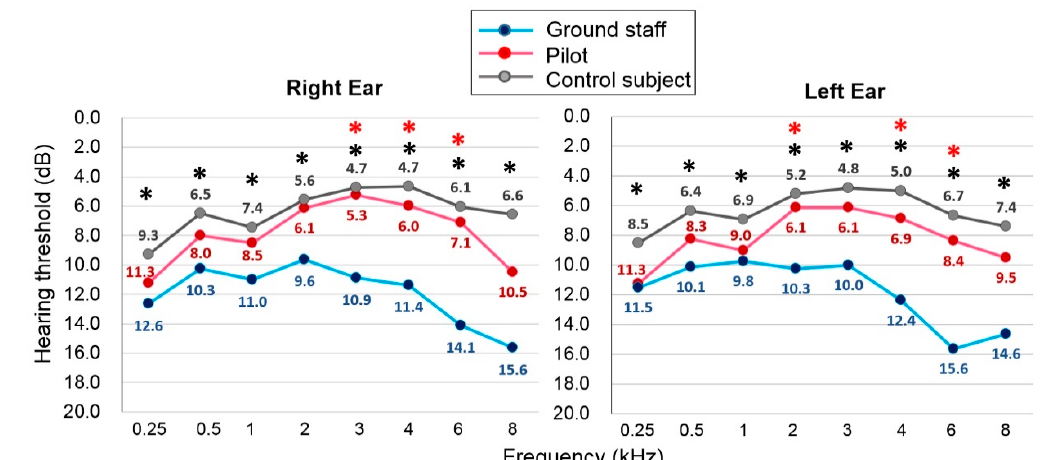
Figure 1. Recent audiometric outcomes assessed with conventional pure-tone audiometry. The value of each data point indicates the average threshold across subjects at the corresponding frequency. Comparisons between groups were performed using the Kruskal—Wallis test, followed by Scheffe’s post-test. * black asterisk indicates p < 0.05 when comparing the ground staff group with the control subjects. * red asterisk indicates p < 0.05 when comparing the ground staff group with the pilot group. Table 2. Comparison of the arithmetic mean of the grouped frequency threshold between the groups. Right Ear Left Ear Ground Staff Fighter Pilot Ground Staff Fighter Pilot p- Value p- Value Grouped Frequencies (kHz) Mean ± SEM